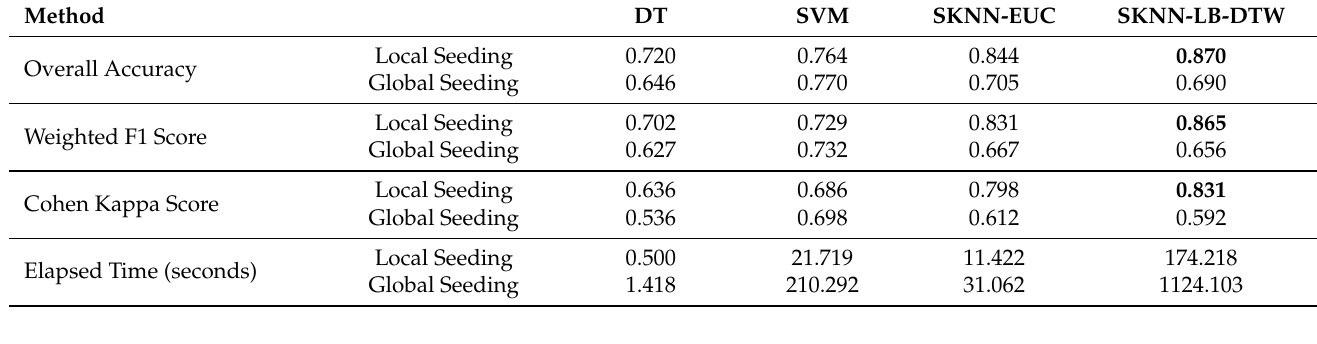
Table 2. Statistical comparison of the classification performance for the second grid.